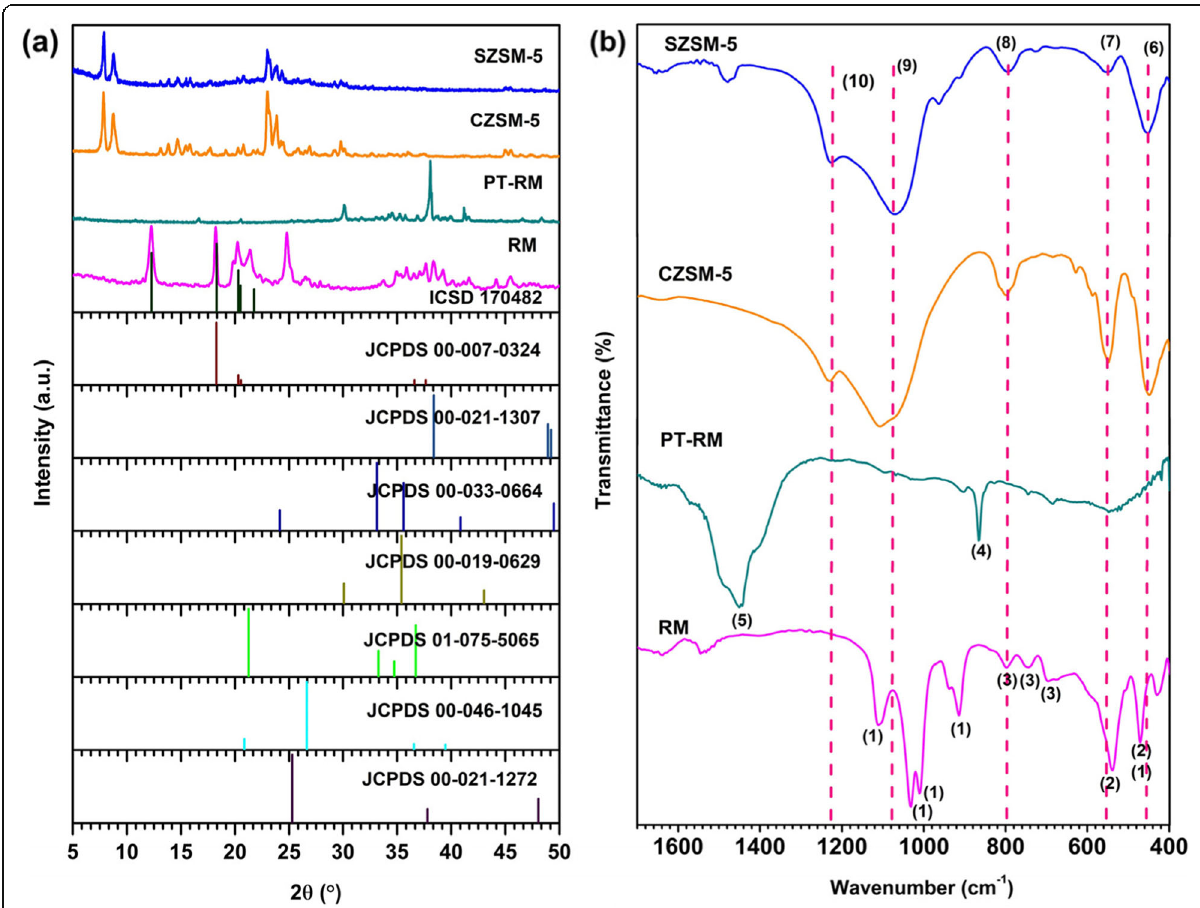
Fig. 2 Confirmation of ZSM-5 formation based on ( a ) XRD results and ( b ) FTIR